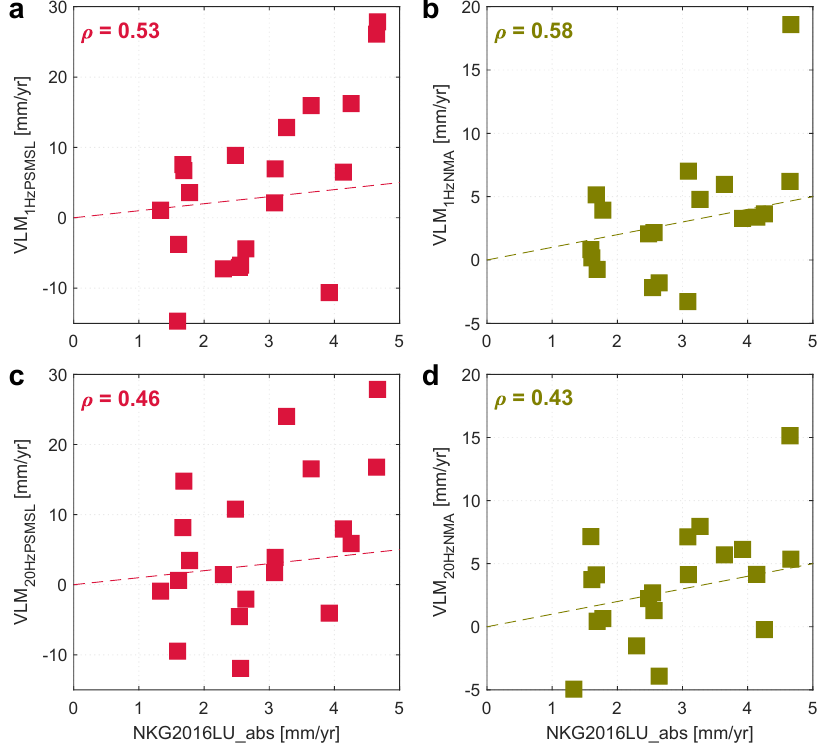
Figure 4. Comparison of estimated VLM rates with rates from NKG2016LU_abs. Spearman’s rank correlation coefficient ρ is shown, which was computed over all 20 tide